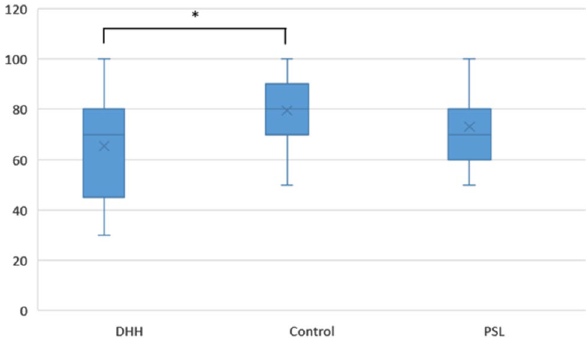
Figure 7. Boxplot of the Performance Test scores across groups, with the minimum and maximum values, median, quartiles 1 and 3. Asterisk indicate significant comparisons ( p <